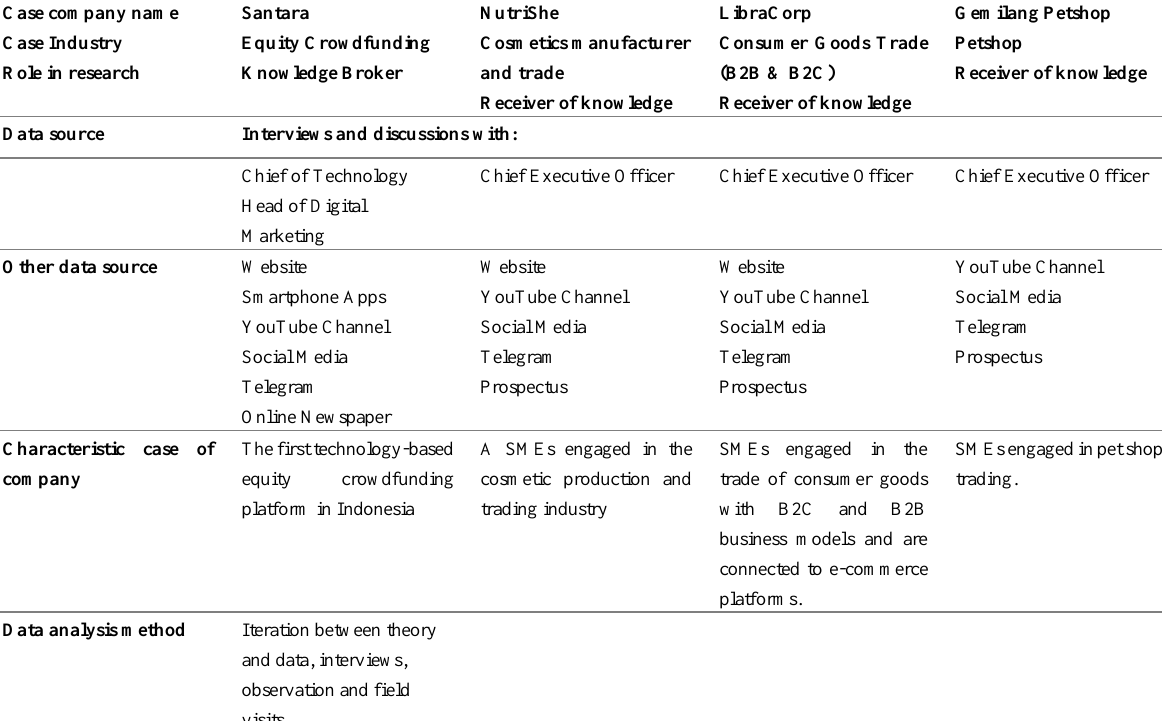
Table 1: Basic information about research